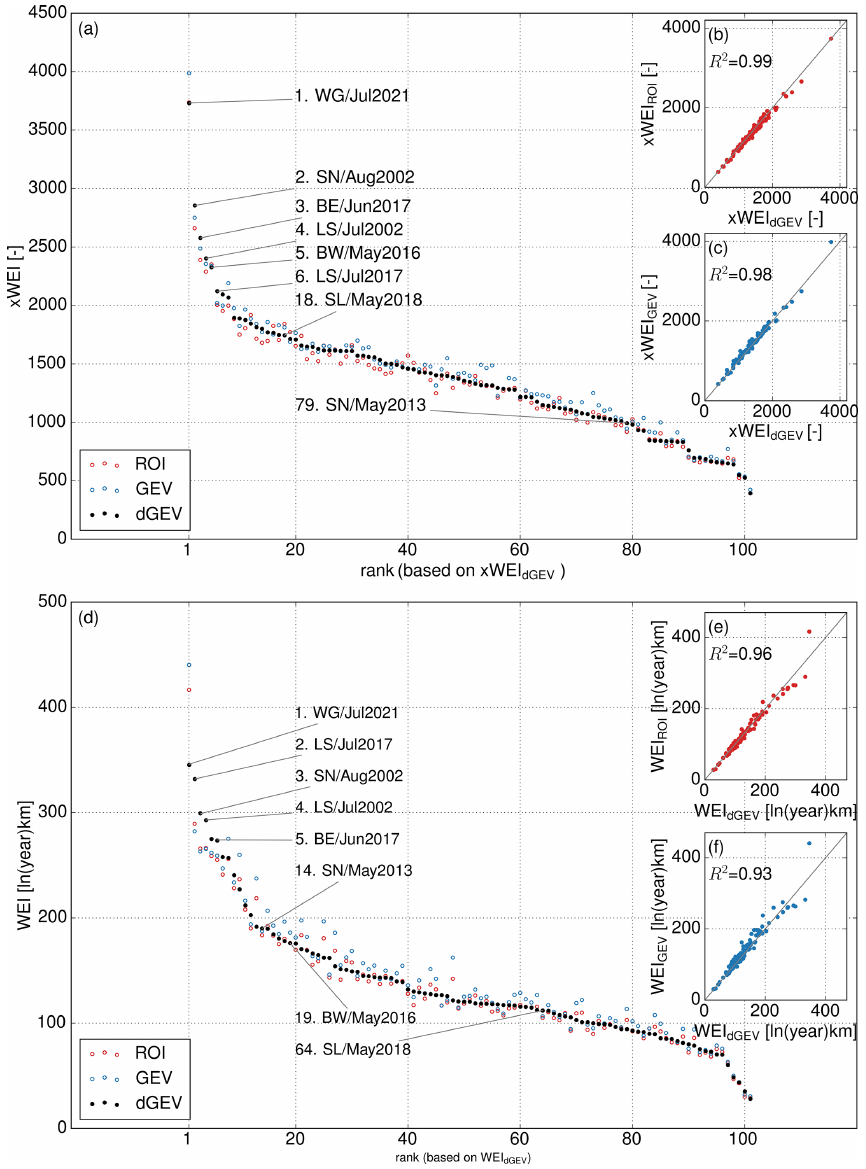
Figure 3. (a) Ranking the 101 most extreme precipitation events according to CatRaRE based on the novel xWEI. The xWEI was calculated with three different methods: cell-wise GEV (blue), region of interest (ROI, red), and duration-dependent GEV (dGEV, black). The ranking was carried out based on the values obtained from the dGEV method. (b) Comparison of dGEV and ROI methods for the calculation of xWEI. (c) Comparison of dGEV and cell-wise GEV. (d) Ranking the 101 most extreme precipitation events according to CatRaRE based on the WEI. (e) Comparison of dGEV and ROI methods for the calculation of WEI. (f) Comparison of dGEV and cell-wise GEV methods for the calculation of